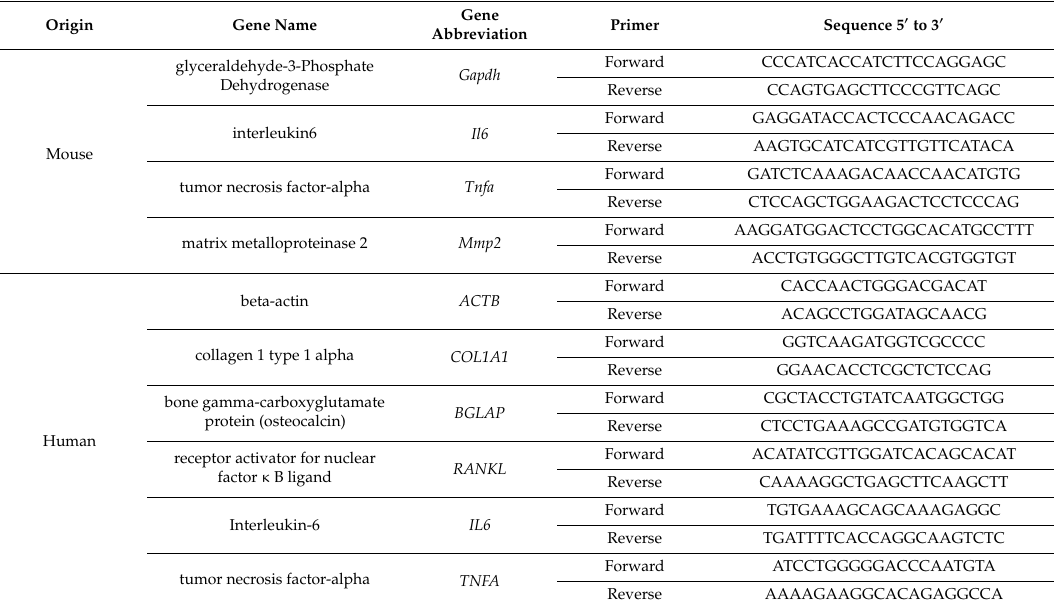
Table 3. Primer sequences for Real-Time